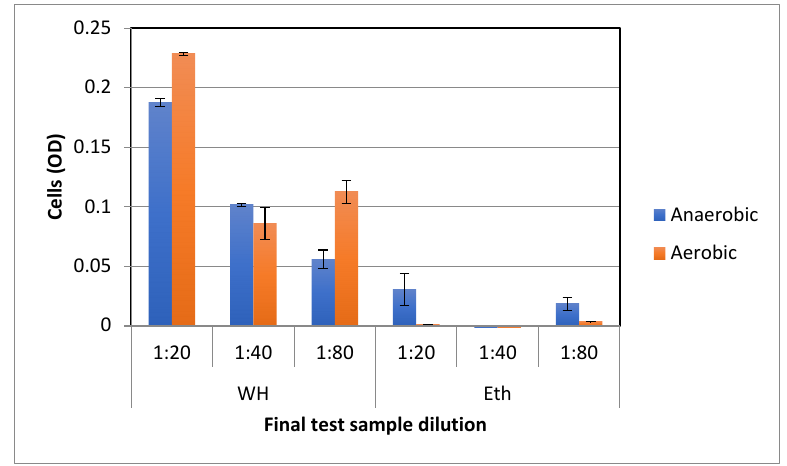
Figure 6. The effect of witch hazel on anaerobic vs. aerobic growth of L . plantarum in nutrient broth. Bacteria were grown overnight in nutrient broth in the presence of increasing amounts of whISOBAX (WH) or ethanol (Eth) control. After 48 h, OD was determined.